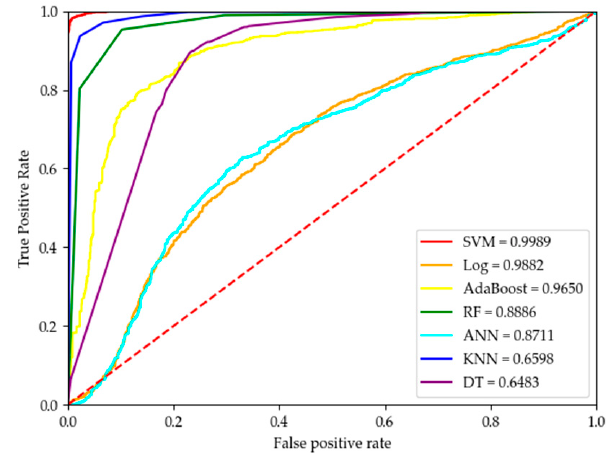
Figure 9. ROC curve of seven classifier models.